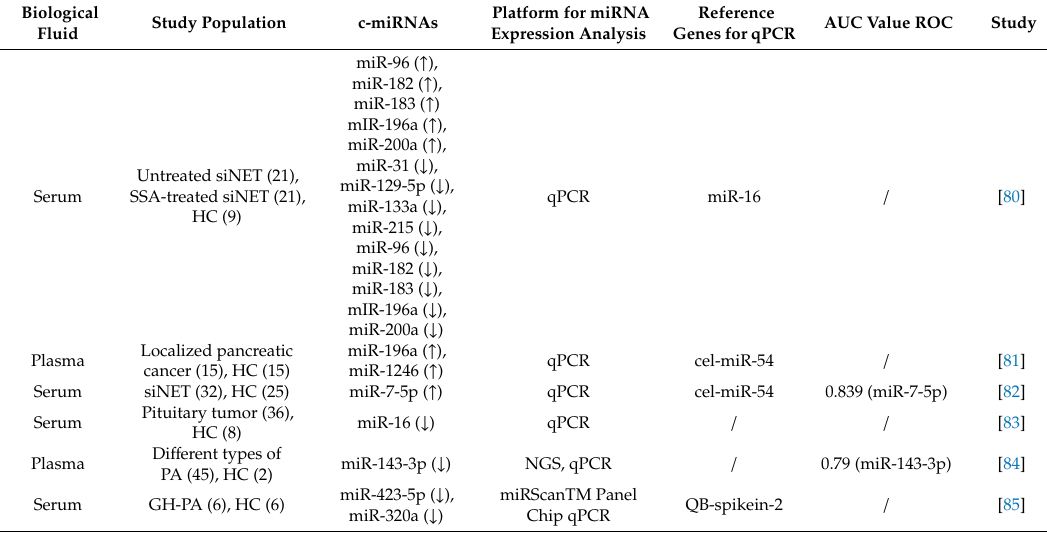
Table 4. Overview of c-miRNAs as candidate biomarkers in sporadic non-MEN1 associated tumors. Biological Fluid